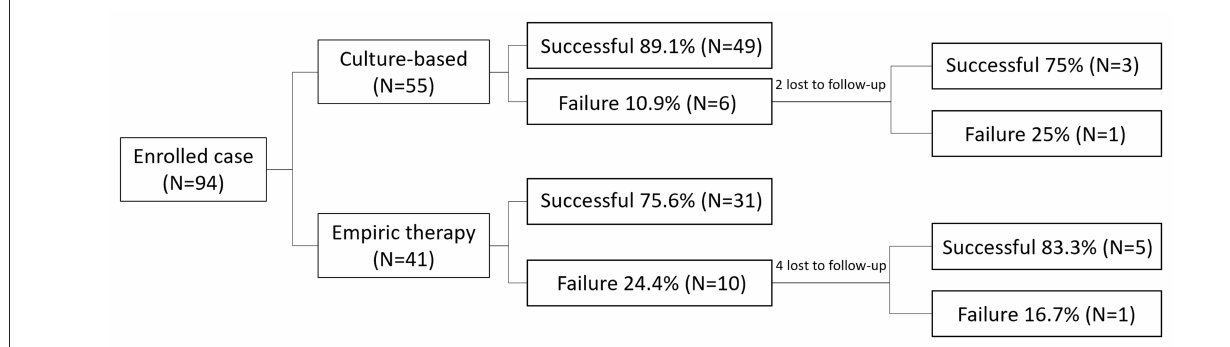
FIGURE 1 | The eradication rates and number of cases in the two groups.